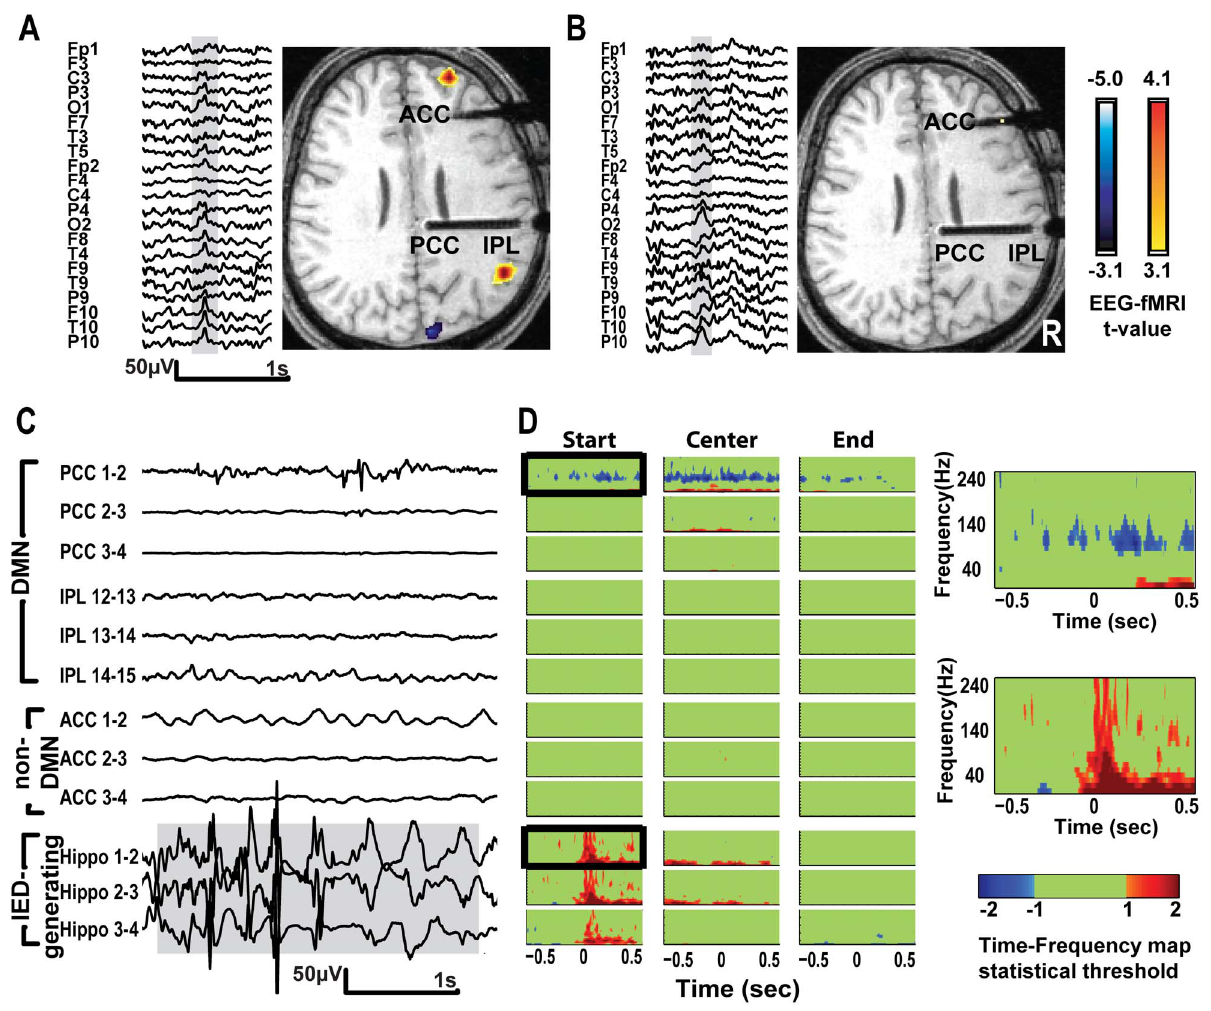
Figure 3. EEG-fMRI results and Time-Frequency (TF) statistical maps of SEEG recordings from patient 1. A – Scalp EEG showing right temporal IED and the associated BOLD changes. Functional map is co-registered to anatomical MRI acquired with the SEEG electrodes, showing the sampling of PCC, IPL and ACC. Functional maps show significant activations in right frontal and parietal lobes and deactivation in cuneus. B - Right posterior temporal-occipital sharp wave was associated with right inferior temporal activation and left central deactivation (not shown in figure). EEG- fMRI did not show DMN deactivation in A&B. C - SEEG traces showing typical runs of hippocampal IEDs (lower 3 traces) and SEEG in PCC, IPL and ACC. Most medial channel in PCC (upper trace) shows propagation of epileptic activity. D – TF plots comparing IEDs with baseline in PCC, IPL, ACC and the IED-generating channel (hippocampus). TF maps are centered at the start, center and end of IED, showing statistically significant increase in frequencies , 30 Hz in the PCC (reflecting spike propagation) and decrease in gamma coinciding with the hippocampal IED. Boxed TF maps shown in higher magnification on the right illustrate power change in PCC and IED-generating channel. Power decrease in PCC is in 80–140 Hz band, and starts 250 ms before IED